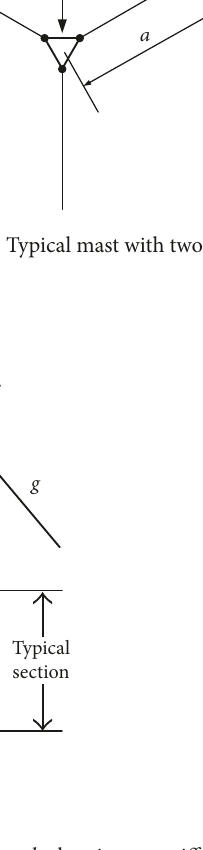
Figure 2: Structure of the shaft: 𝐿 : leg, 𝑏 : bracing, 𝑠 : stiffener members, 𝑔 : guy, and 𝑎 : auxiliary